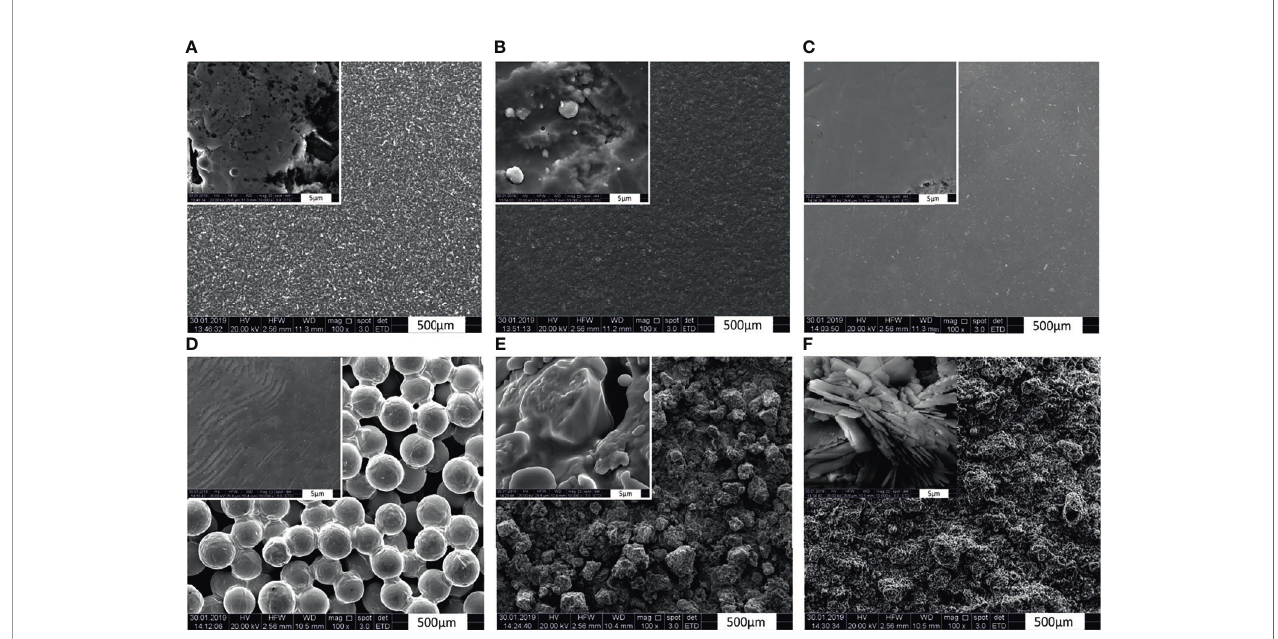
FIGURE 2 | Scanning electron microphotographs of CoCrMo and the different surface modi fi cations. Magni fi cation factor ×100, and inlays ×10,000. (A) CoCrMo; (B) CoCrMo TiN; (C) CoCrMo polished; (D) CoCrMo porous coated; (E) CoCrMo cpTi, (F) CoCrMo TCP.